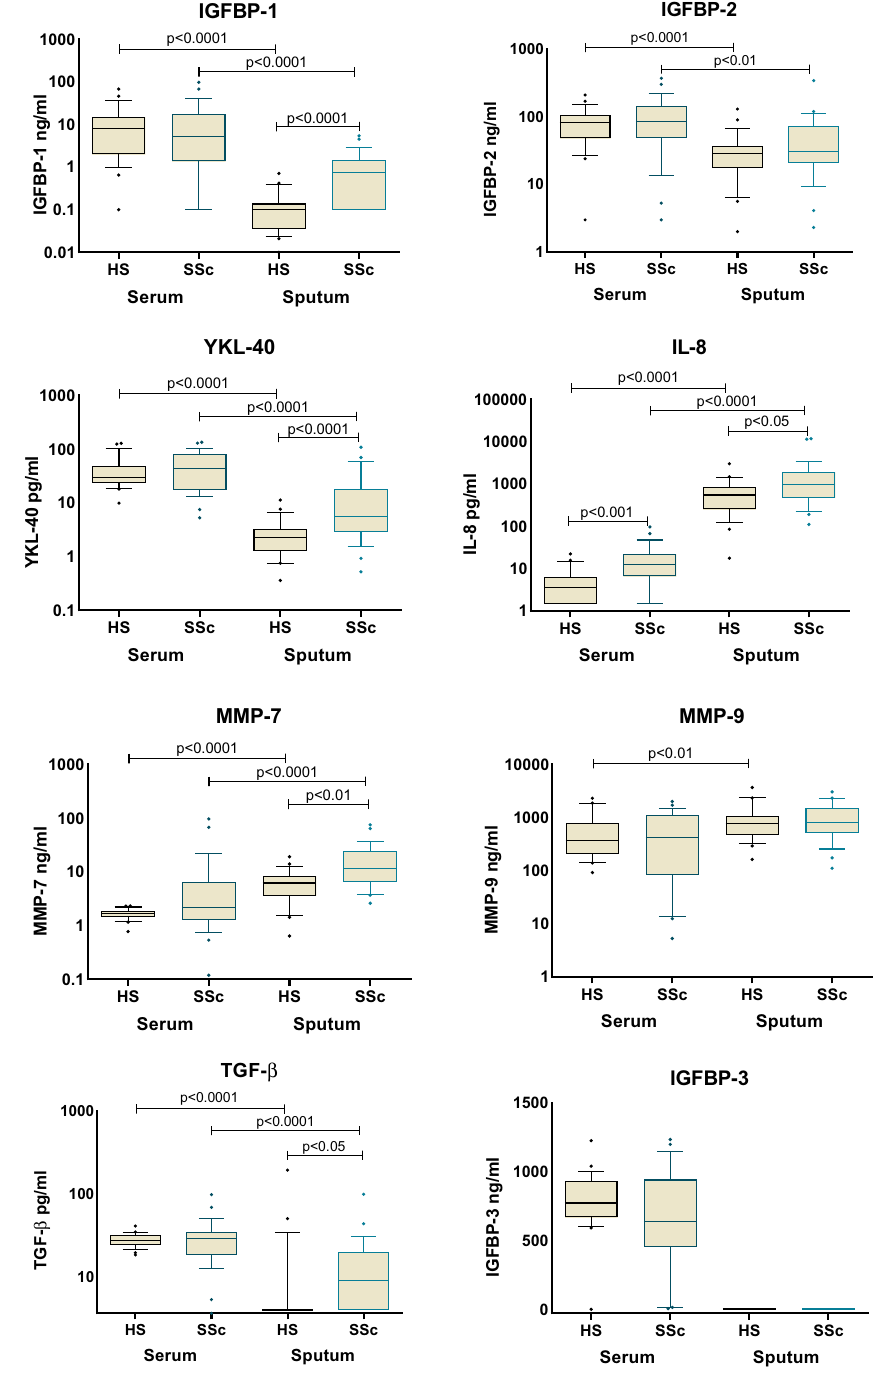
Figure 1. Comparison serum/sputum